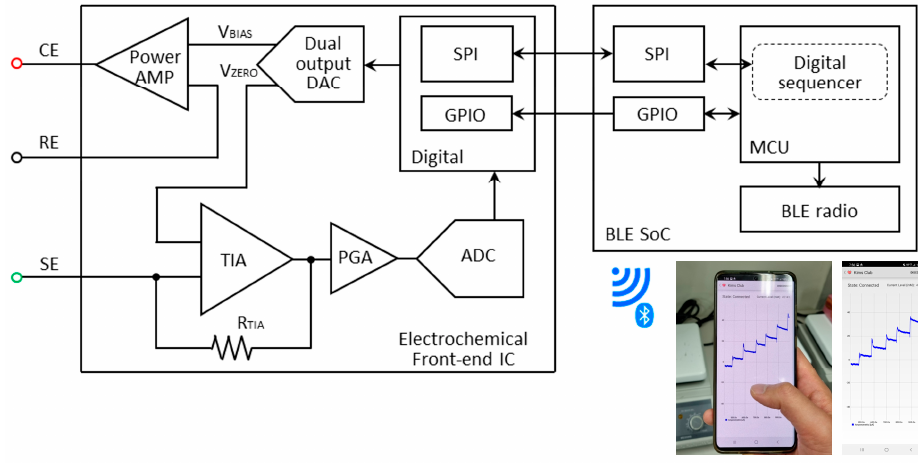
Figure 2. Block diagram of the wireless glucose monitoring